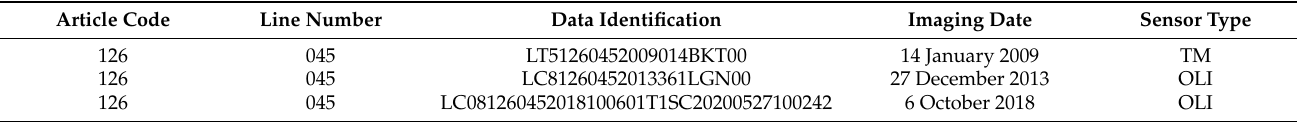
Table 1. Landsat remote sensing image information.